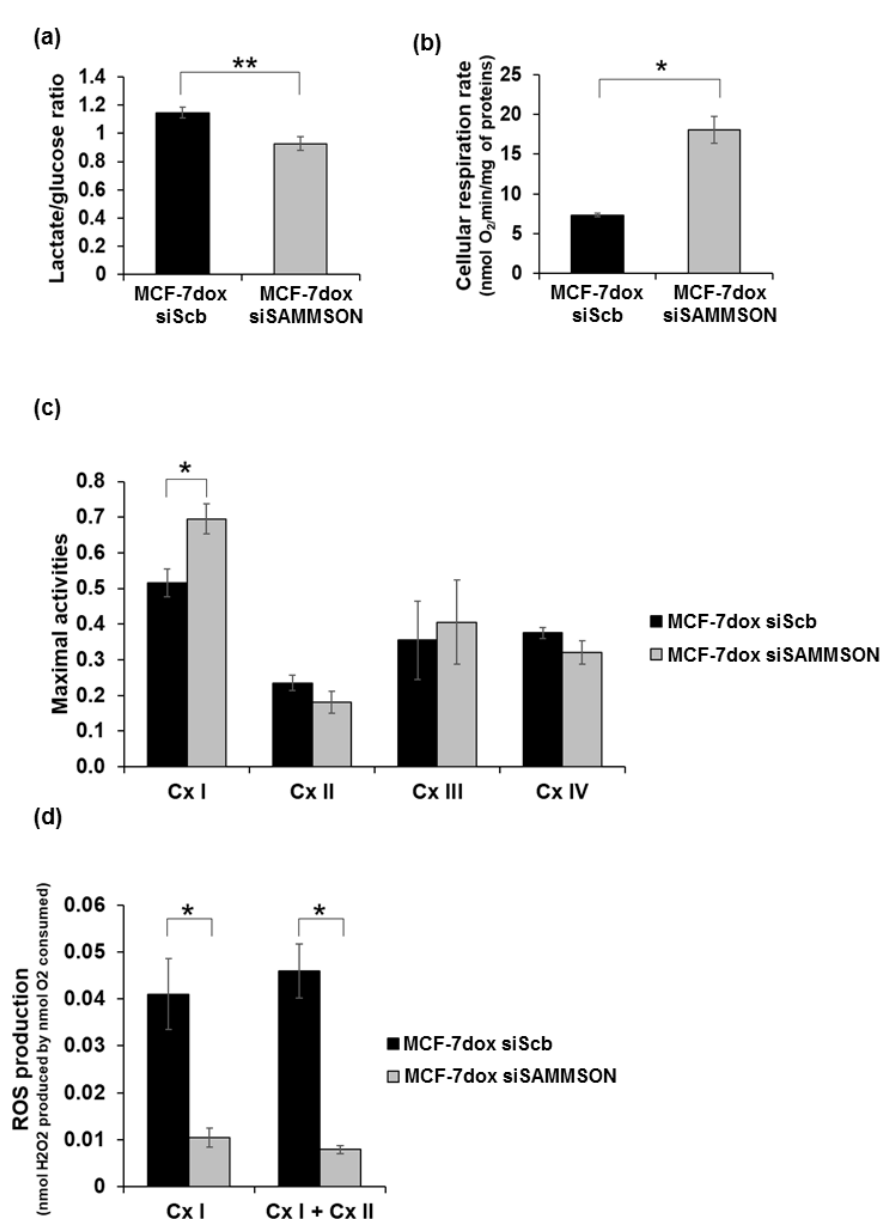
Figure 2. Evaluation of the metabolic orientation following SAMMSON silencing in MCF-7dox cells. ( a ) Estimation of glycolytic metabolism by calculating the ratio between lactate production and glucose consumption in MCF-7dox siScb and MCF-7dox siSAMMSON culture supernatants. The data are represented by the mean ± SEM of n = 6 for the MCF-7dox siScb and siSAMMSON cells. ( b ) Assessment of the oxidative metabolism on intact cells in glucose medium estimated by measuring the routine respiration rates in MCF-7dox siScb and MCF-7dox siSAMMSON cells. Raw data were normalized to the total amount of proteins. The data are represented by the mean ± SEM of n = 4 for the MCF-7 dox siScb and siSAMMSON cells. ( c ) Maximal activities of respiratory chain complexes I, II, III and IV were measured in duplicate on cell lysates from MCF-7dox siScb and siSAMMSON cells. Results were normalized to citrate synthase activity. Data are represented by the mean ± SEM of n = 7 for